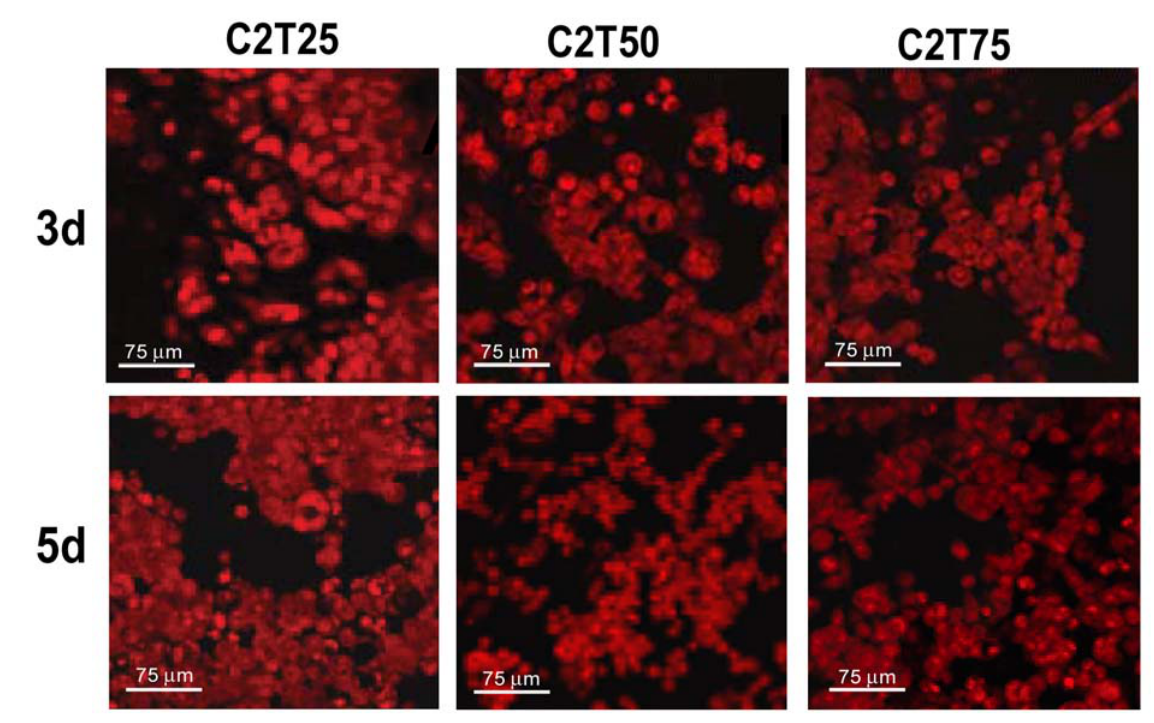
Figure 2. Confocal microscopy of J111 cells grown for 3 and 5 days on membranes made of different ratios of type I collagen from tendons and type II collagen from trachea cartilage (see Experimental Section). Cells were labeled with propidium iodide prior to microscopy observation.